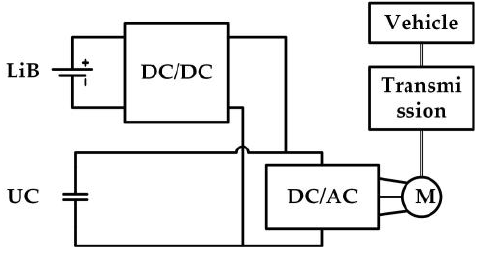
Figure 1. Semi-active HESS structure.